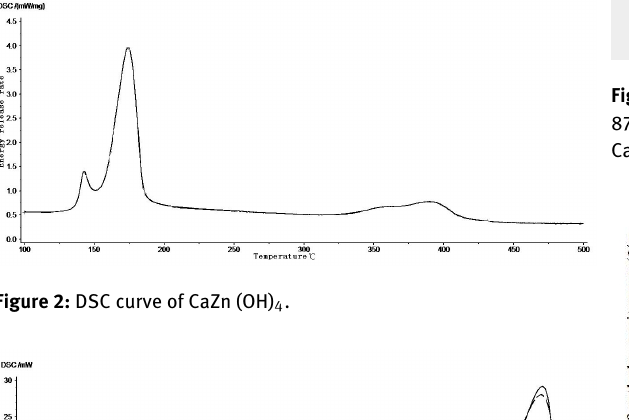
Figure 2: DSC curve of CaZn (OH) 4 .